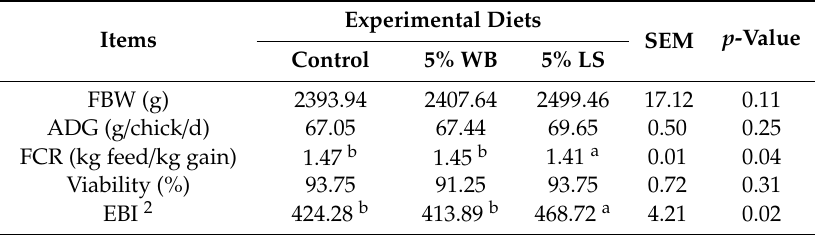
Table 1. E ff ects of the LS supplementation on the growth performance of 35-day-old broilers 1 . Items